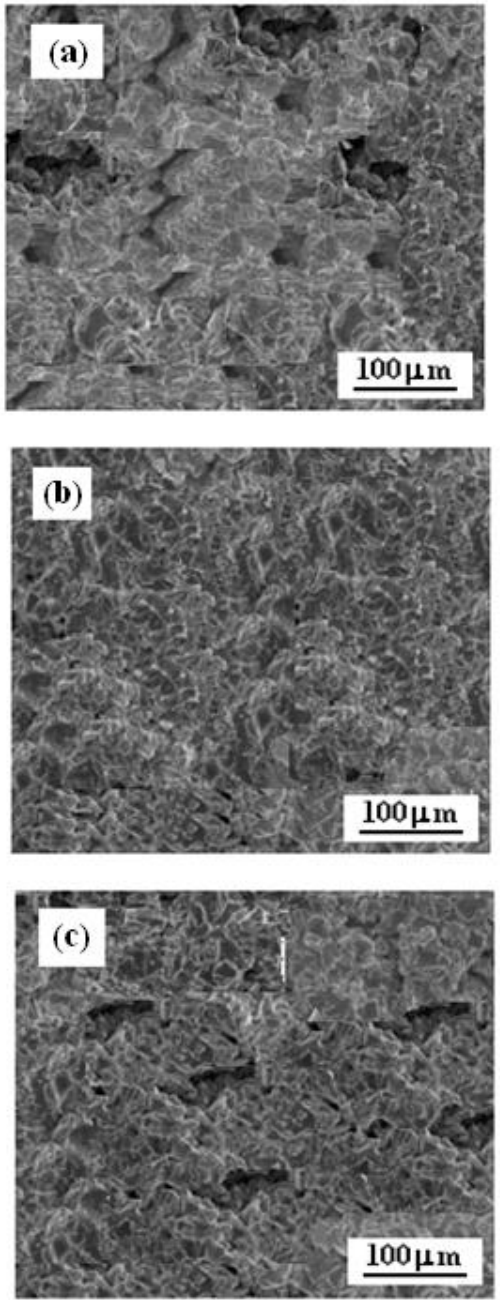
Figure 3. Surface morphologies of cold sprayed titanium coatings onto Al7075 substrate deposited at SoD of: ( a ) 20 mm, ( b ) 70 mm, and ( c ) 100 mm.